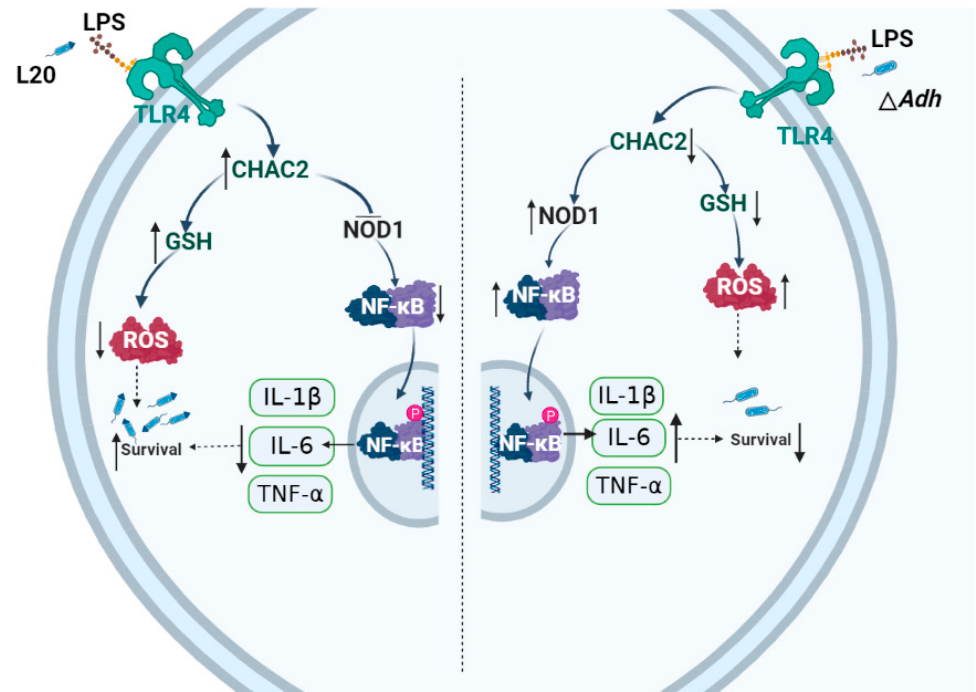
Figure 6. The mechanism of A. pleuropneumoniae immune escape mediated by CHAC2 . The Adh domain of A. pleuropneumoniae increases CHAC2 expression of macrophage through the LPS-TLR4 pathway. CHAC2 can further suppress the ROS by GSH, and IL-1 β , TNF- α , and IL-6 expression via the NOD1/NF- κ B signaling pathway in PAM. CHAC2 , cation transport regulatory-like protein 2; GSH, Glutathione; ROS, reactive oxygen species. This figure was created with